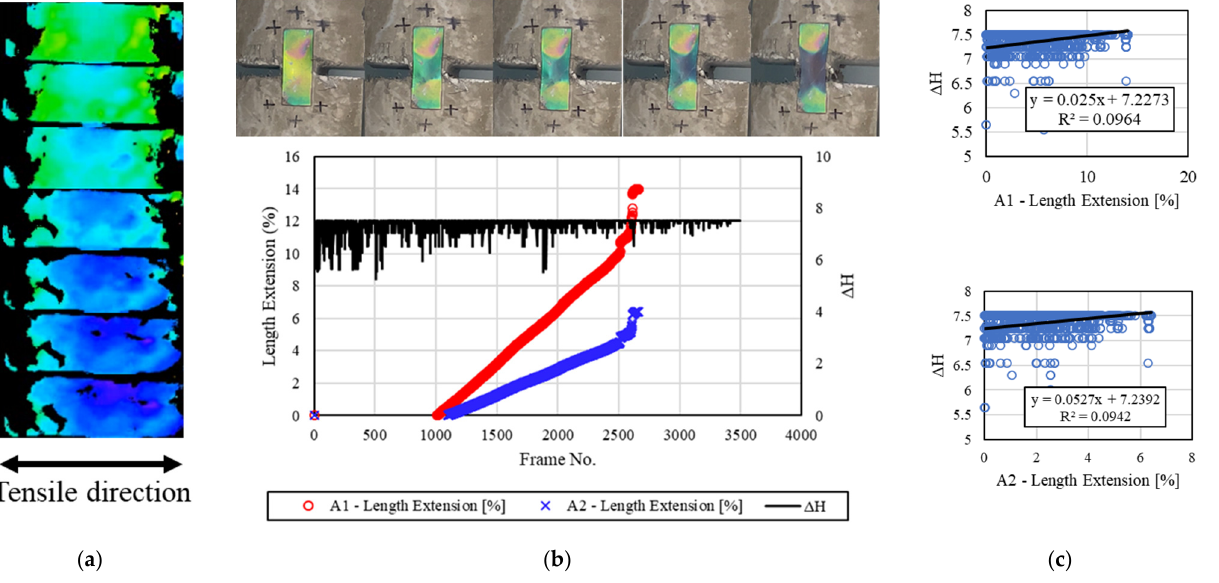
Figure 11. Results for the specimens after 3.0 h. ( a ) H-value image for discoloration color of mechanochromic sensor (90° rotation relative to tensile direction); ( b ) variations in strain and dH of A1 and A2 according to image frame. (The discoloration process of the mechanochromic sensor attached to the specimen and the tensile strain described in Figure 3 are shown.); ( c ) correlations of dH with A1 and A2.